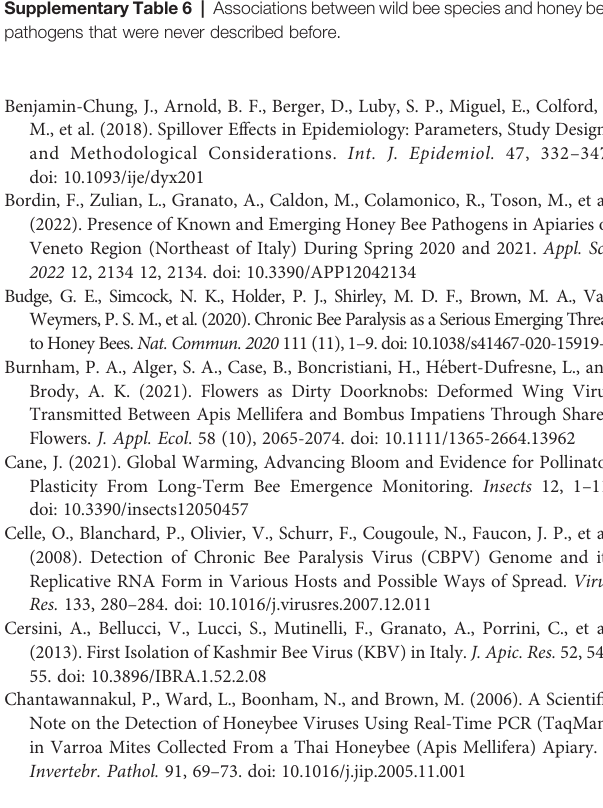
Supplementary Figure 1 | Virusabundance related to the site, month, and genus. Data are presented log10 transformation for better visualization. Means are visualized are red dots. Different number of asterisks indicate statistical differences from base average: p-value<0.05 (*); p-value<0.01 (**); p-value<0.001 (***). Supplementary Figure 2 | DNA pathogen abundance related to the site, month, and genus. Data are presented log10 transformation for better visualization. Means are visualized are red dots. Different number of asterisks indicate statistical differences from base average: p-value<0.05 (*); p-value<0.01 (**); p-value<0.001 (***). Supplementary Table 1 | Individual pathogen abundance of the collected samples, grouped by genus, species, region, site, and month. Supplementary Table 4 | Wilcoxontestresults.Tablesshowthe signi fi cativitylevel of each paired test for each pathogen in different sites, months and genera. Only p- values<0.05 are shown. All the other comparisons (not shown) have p-values>0.05. Supplementary Table 5 | Accession number of viral sequences, deposited in GenBank. Supplementary Table 6 | Associations between wild bee species and honey bee pathogens that were never described